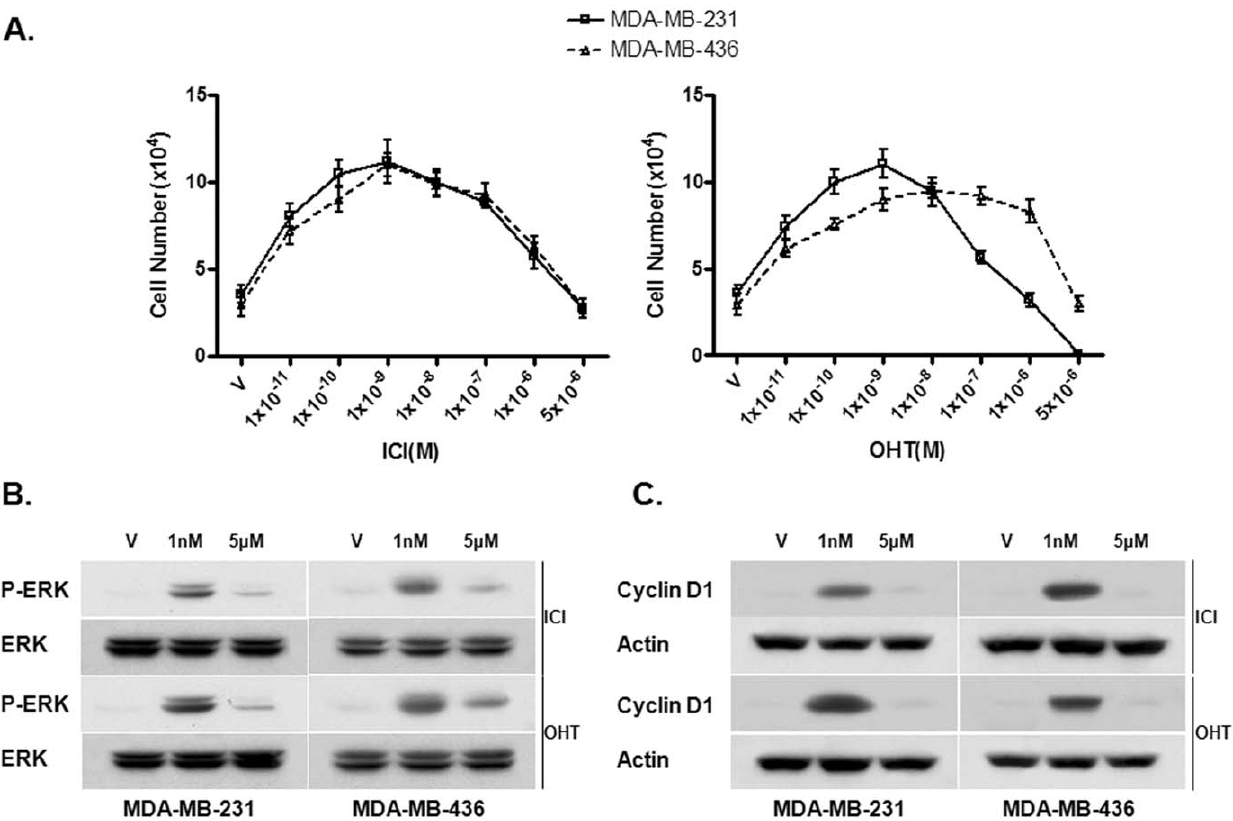
Figure 1. ER-negative breast cancer cells exhibit biphasic antistrogen signaling. (A). The effects of 4-OHT and ICI 182, 780 on the proliferation rate of MDA-MB-231 and MDA-MB-436 cells. Cells maintained for three days in phenol red-free DMEM plus 2.5% dextran-charcoal- stripped fetal calf serum were treated with indicated concentrations of 4-OHT, ICI or ethanol vehicle as a control. The cell numbers were determined using an automatic cell counter after 12 days. Five dishes were used for each concentration and experiments were repeated more than three times. The mean cell number 6 SE are shown. (B). The dose-dependent phosphorylation pattern of the MAPK/ERK1/2 in MDA-MB-231 and MDA-MB-436 cells treated with different concentrations of antiestrogens. Starved cells were treated with indicated doses of 4-OHT or ICI 182, 780 (ICI) for 10 min. Western blot analysis was performed to assess induction of ERK1/2 phosphorylation. The experiment was repeated more than three times. The representative results are shown. (C). The dose dependent induction Cyclin D1 by antiestrogens in MDA-MB-231 and MDA-MB-436 cells. The experiment was repeated more than three times. The representative results are shown.